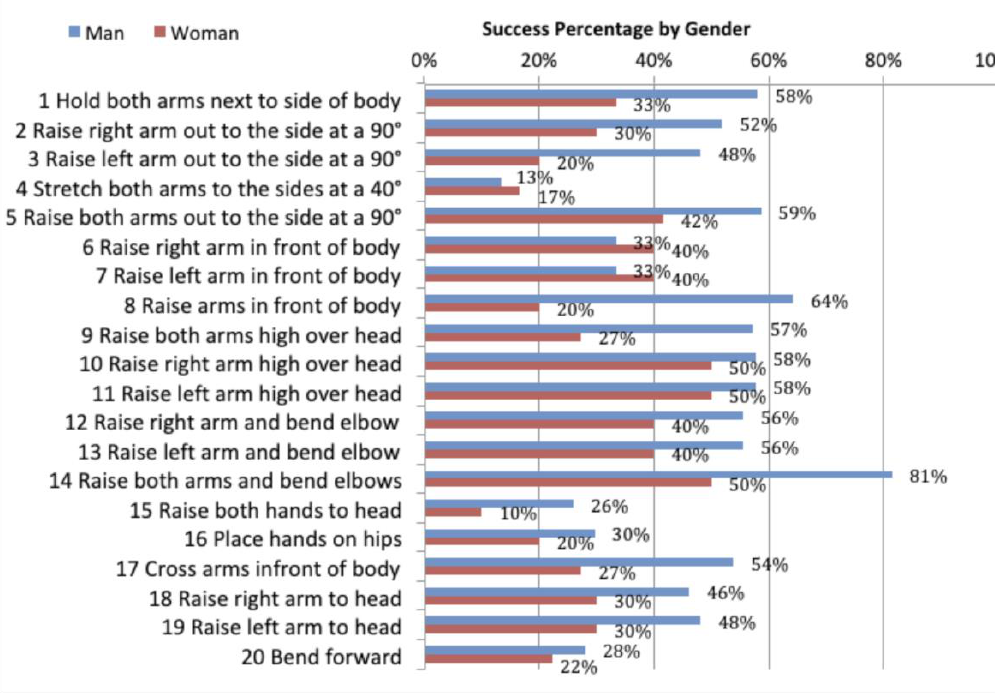
Figure 8. Success rate of Kinect gestures by gender. Table 5. Contingency table.